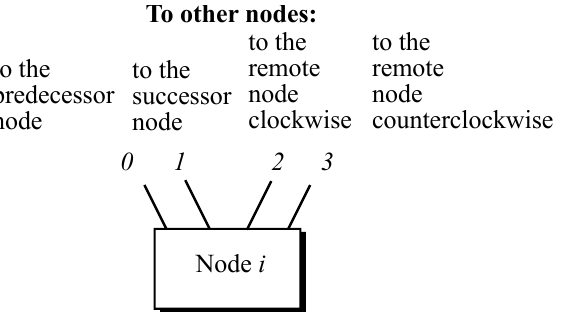
Figure 8. Robertson graph node with ports linking to their neighboring nodes.